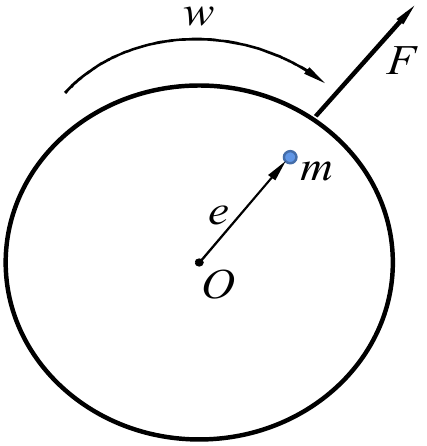
m is the eccentric mass; e is the eccentric w is the angular velocity.